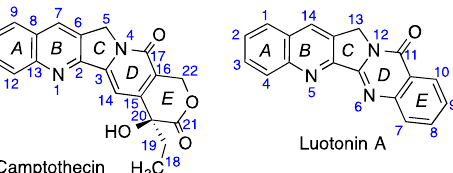
Figure 1. Structures and numbering of camptothecin and luotonin A.